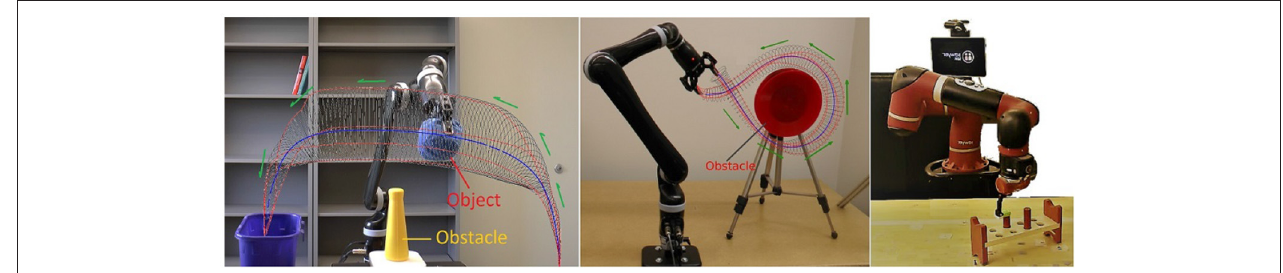
FIGURE 1 | Two robots reproducing three trajectory-based skills encoded and learned using